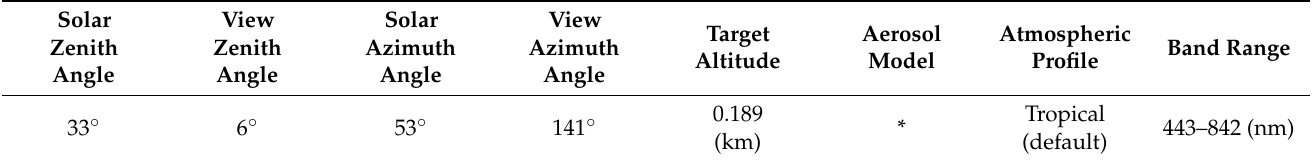
Table A2. Atmospheric parameters and geometric conditions (viewing and illumination) used in the theoretical